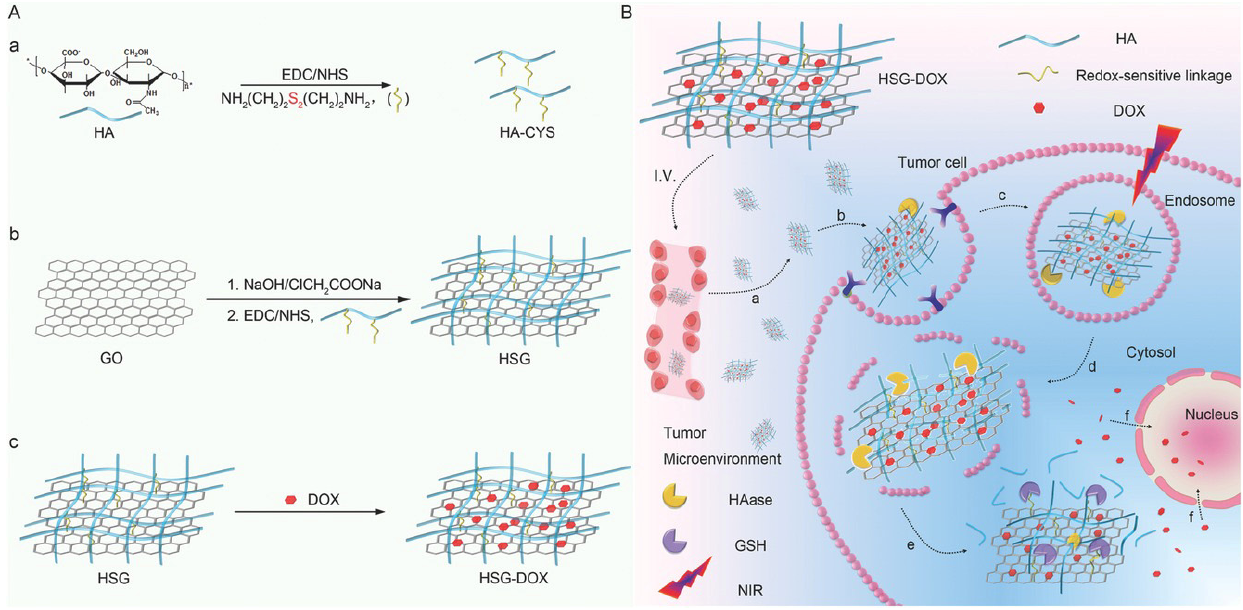
Figure 7. ( A ) Synthesis of bioreducible HA-GO-DOX (HSG-DOX) nanosheets. ( a , b ) HA is bound to graphene oxide (GO) using cystamine as a redox-sensitive linker or adipic dihydrazide as a redox- insensitive linker. ( c ) DOX loading on the so-modified graphene. ( B ) NIR-controlled endo/lysosomal escape and rapid release of DOX in cytoplasm induced by glutathione: ( a ) accumulation of HSG-DOX within the tumor site through passive and active targeting; ( b , c ) receptor-mediated cellular internalization; ( d ) hyaluronidase-mediated HA degradation in endosomes and NIR-mediated endo/lysosomal escape; ( e ) GSH triggered HA detachment and rapid DOX release in cytoplasm; ( f ) accumulation of DOX in nucleus for DNA damage-mediated apoptosis and cytotoxicity. Reproduced with permission from [182]. © 2022 WILEY-VCH Verlag GmbH & Co. KGaA, Weinheim.